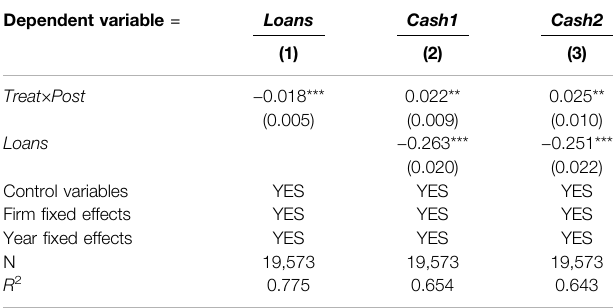
TABLE 8 | Mechanism analysis: Bank loans.